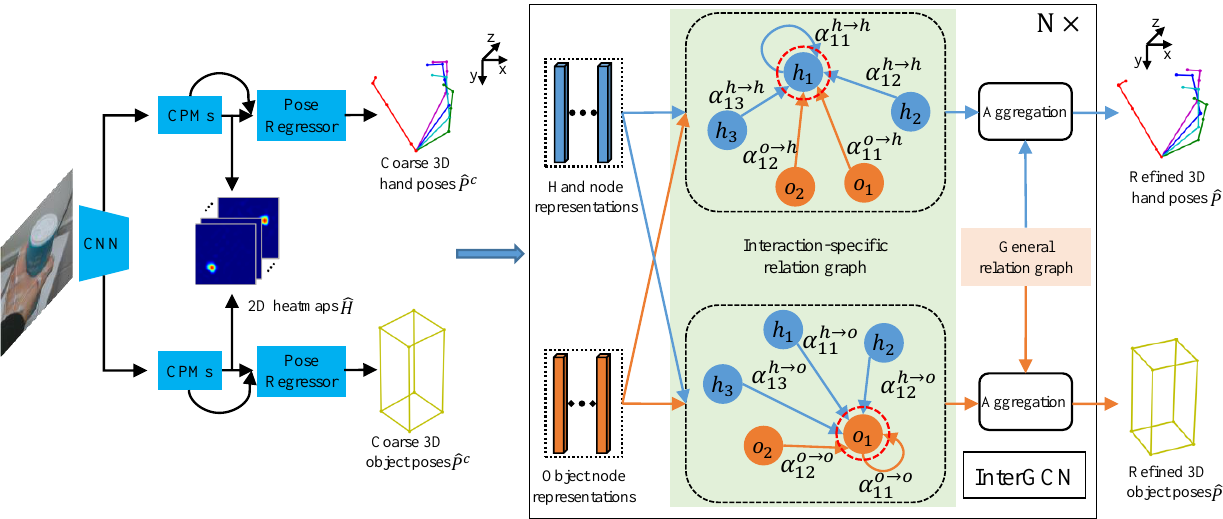
Figure 2. The overview of the proposed coarse-to-fine framework. Our method consists of two stages: coarse stage and fine stage. In the coarse stage, hand and object keypoint heatmaps are first obtained from input image. Subsequently, the heatmaps are passed to the pose regressor to generate coarse 3D hand–object poses. As for the fine stage, InterGCN is introduced to refine coarse hand–object poses estimated in the previous stage by leveraging the general relation graph (Section 3.2.2) and interaction-specific relation graph between hand joints and object corners in 3D